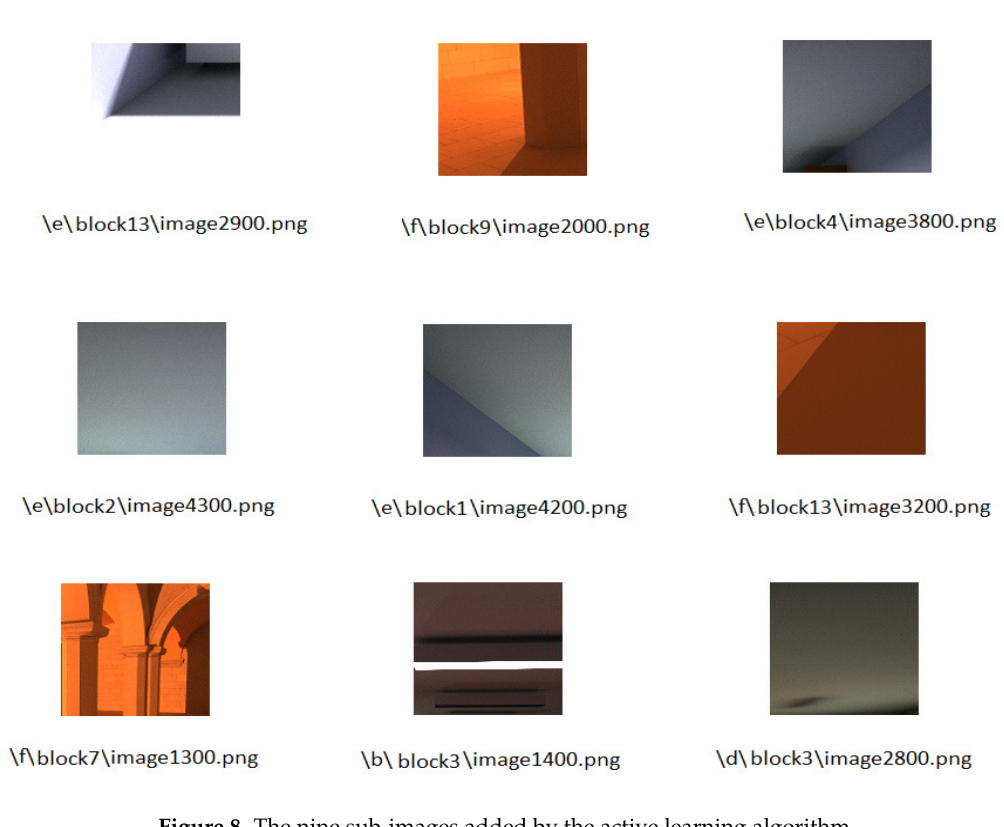
Figure 8. The nine sub-images added by the active learning